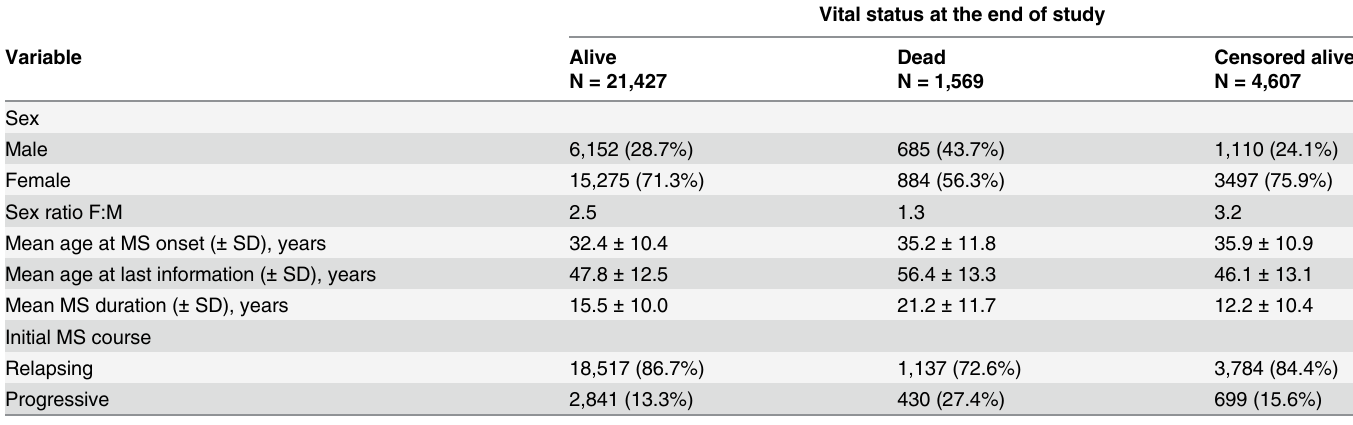
Vital status at the end of study